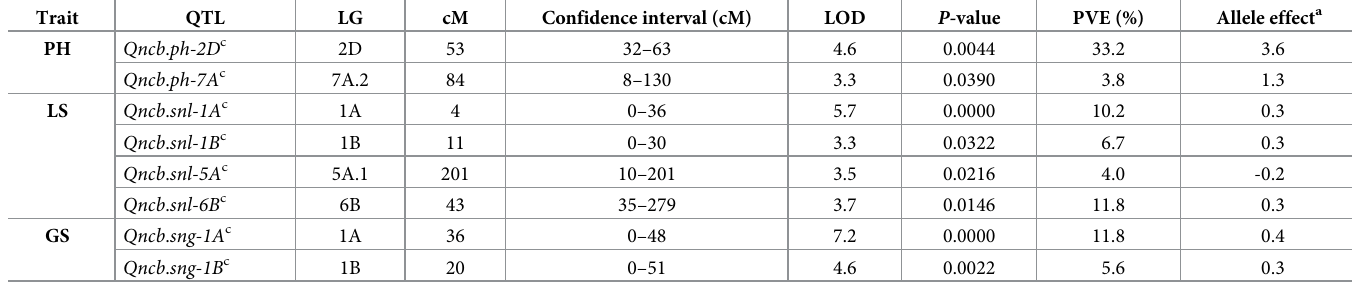
Table 3. Quantitative trait loci (QTL) in the GADH population associated with heading date, plant height, and disease severity combined across years, using the standard interval mapping (SIM) approach with three major phenology genes as covariates for SNB resistance.